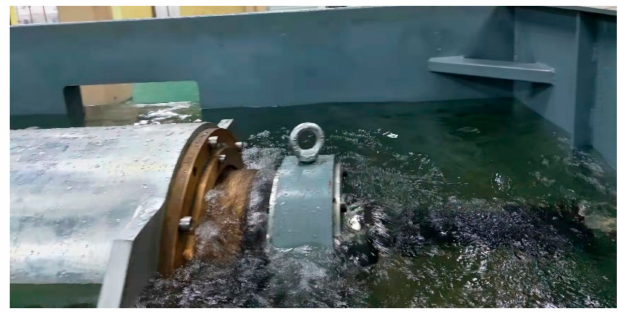
Figure 3. Pictures of test equipment in